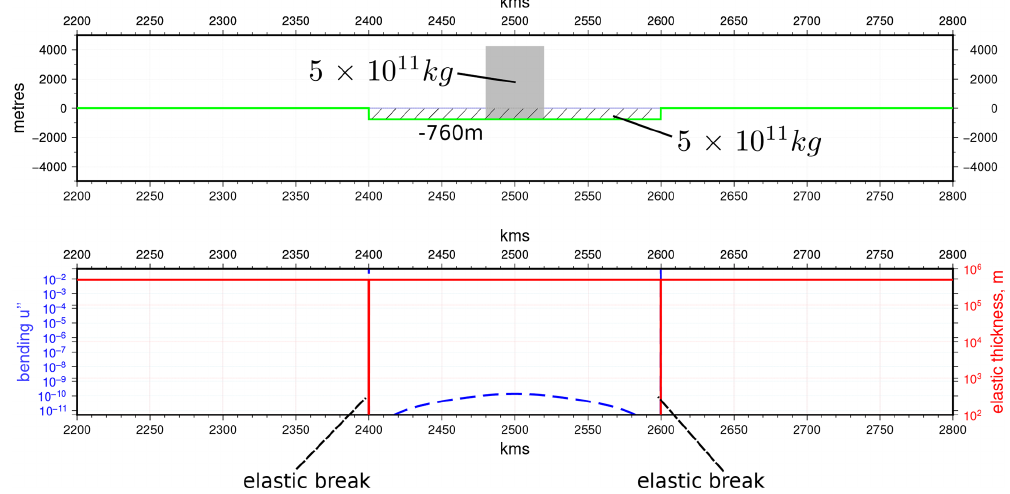
Figure 6. Isostatic “raft” model. With an effectively infinite thickness plate and a symmetrically loaded raft, which is detached at both ends by elastic breaks ( h = 0 . 01 m for three nodes), the mass of mantle displaced (760m thick layer) is almost exactly equal to the mass of the applied load, demonstrating isostatic balance without flexure (for parameters used, see Table A1). Figure prepared using GMT v6.0.0 (Wessel et al.,